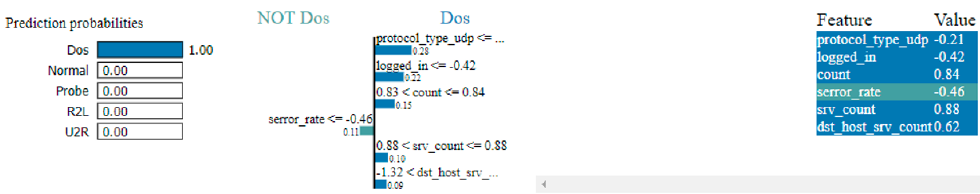
Figure 7. LIME local explanation of DoS vs. NOT DoS attack.